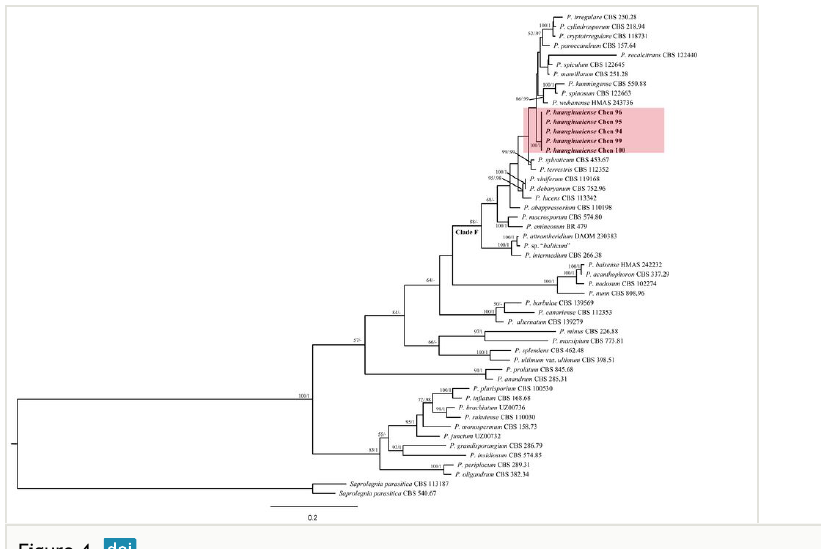
Figure 4. Phylogeny of Pythium huanghuaiense and related species generated by Maximum Likelihood, based on ITS+ Cox1 sequences. Branches are labelled with parsimony bootstrap proportions (before slanting line) higher than 50% and Bayesian posterior probabilities (after slanting line) more than 0.95. The branch of the new species is highlighted in pink.